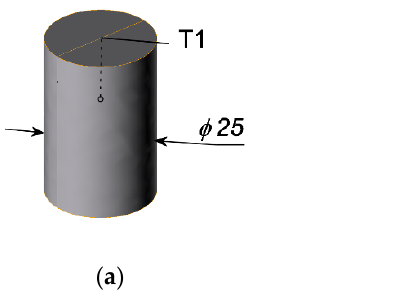
measurement of cooling rate is described in [31]. Recorded relationships between the tem- perature inside the test probe, T s , and the cooling time, τ , were used for calculating the relationships between the heat transfer coefficient, α , and the surface temperature, T p , by the numerical solution of the inverse problem of heat conduction equation using Weber method [32]. The relationships between cooling rate, v c , and temperature, T , were also calculated.